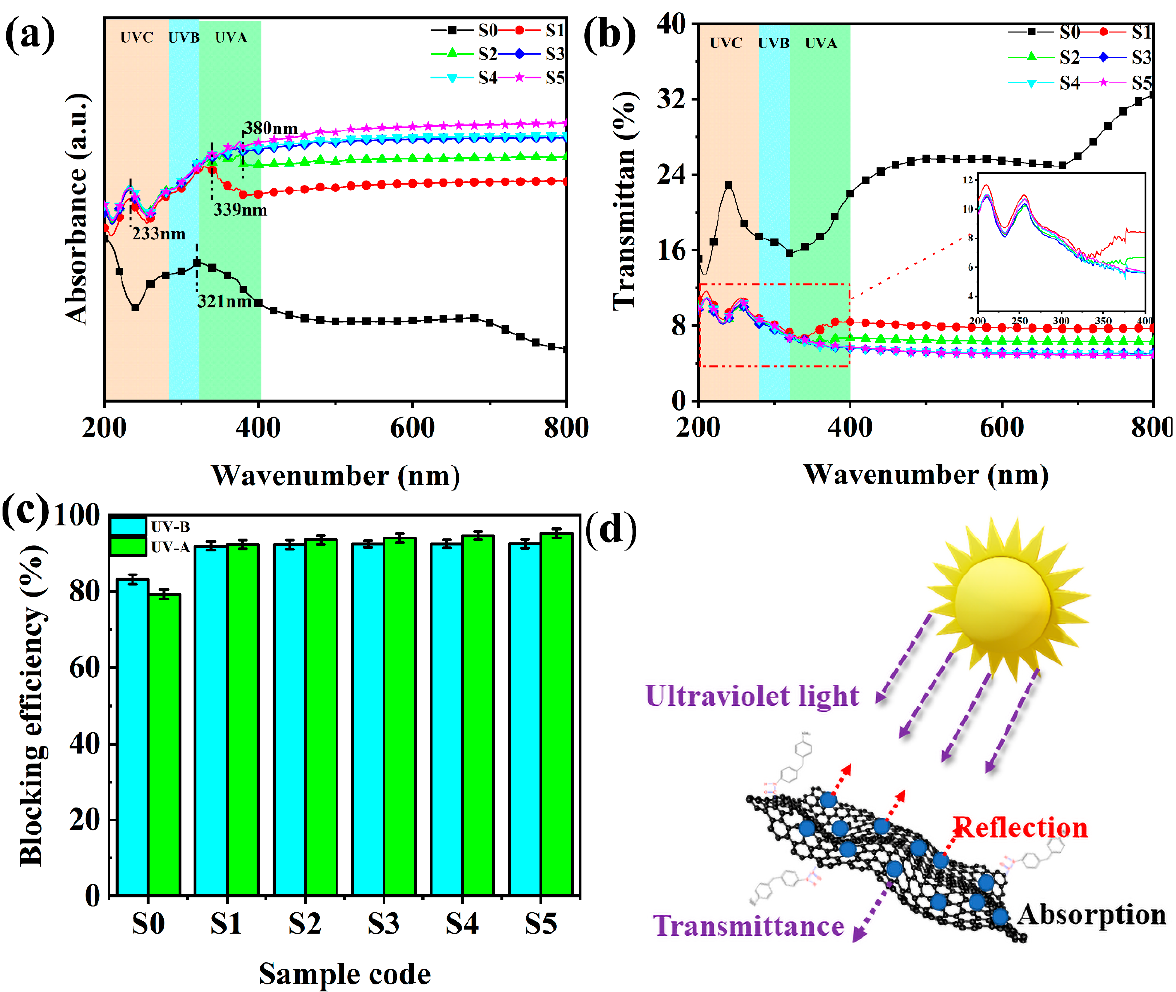
Figure 6. ( a ) Absorbance, ( b ) Transmittance, ( c ) UV shielding performance comparison of TPU composites, ( d ) Diagram of the shielding effect of DDM − GO@SiO 2 against UV light. Table 1. Blocking efficiencies of samples in the UV-A and B regions.